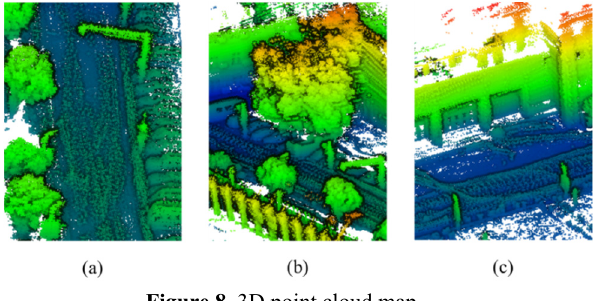
Figure 8. 3D point cloud map